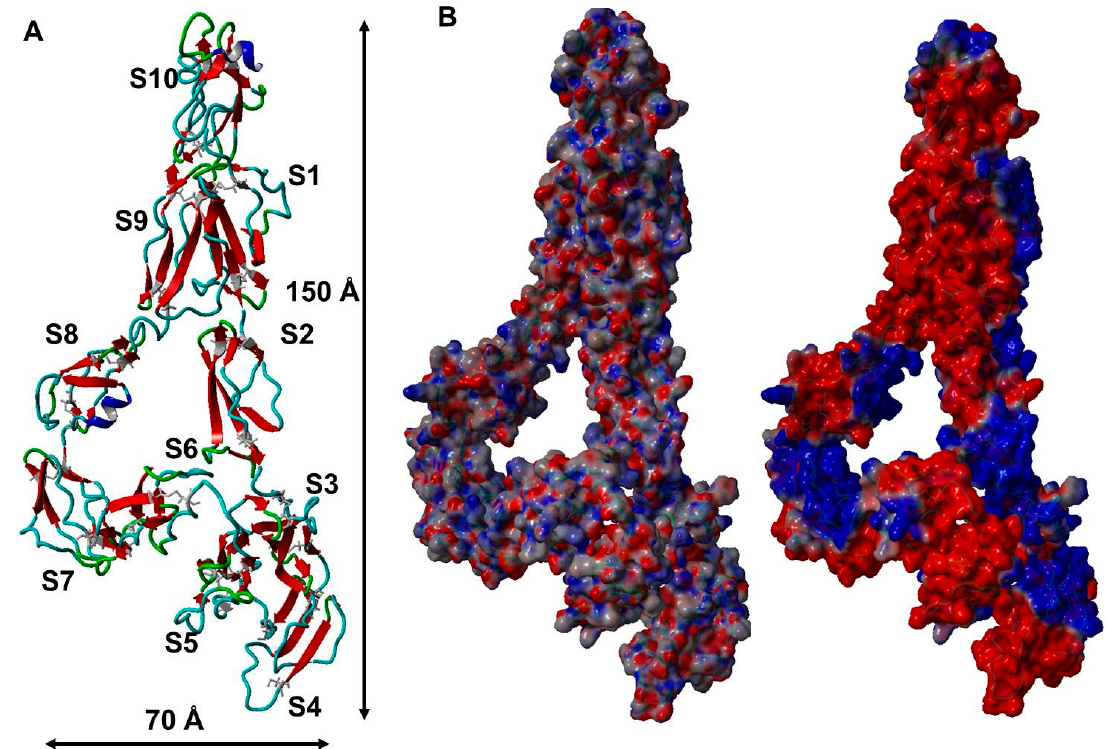
Figure 4. The FXIII-B subunit monomer model. Panel A shows the FXIII-B subunit monomer post-equilibrated model structure in ribbon format. The backbone is colored based on secondary structure. The disulfide-bonded cysteines are represented as grey colored stick forms. The individual sushi domains are numbered S1 to S10; N to C terminal. Panel B is the electrostatic surface representation of the FXIII-B subunit monomer model. The left side of Panel B shows the PBS styled depiction of surface electrostatics while the right side shows the PME styled depiction of surface electrostatic. Calculation and depiction for both forms of electrostatics were performed with macros embedded in YASARA. Red color indicates negative potential while blue represents positive